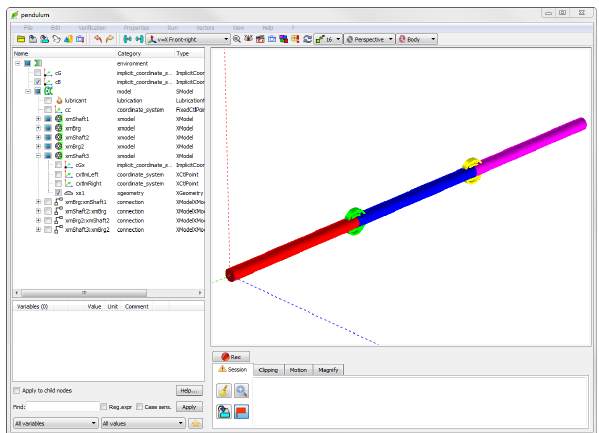
Figure 4: The BEAST composite model editor showing the model of the triple pendulum with rolling bearings.